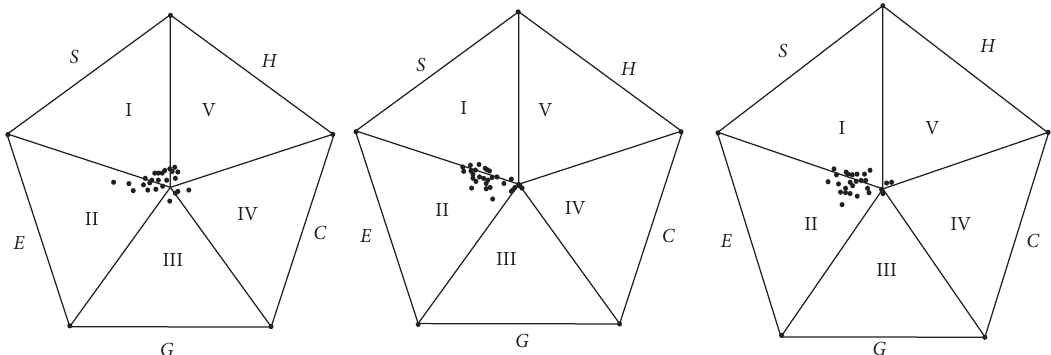
Figure 5: Pentagon model based on ecological civilization construction data. (a) 2000. (b) 2008. (c)